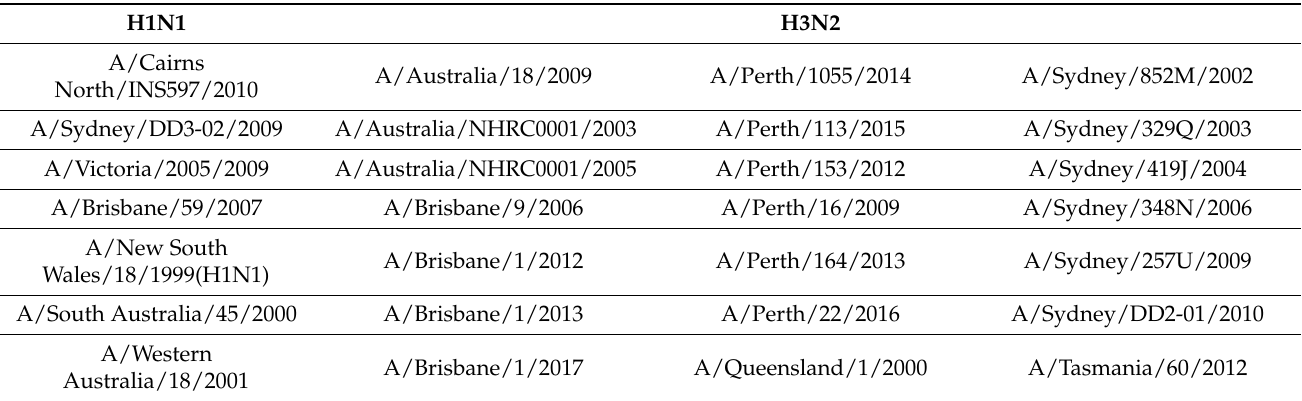
Table 3. All the IAV strains used for epitope conservation